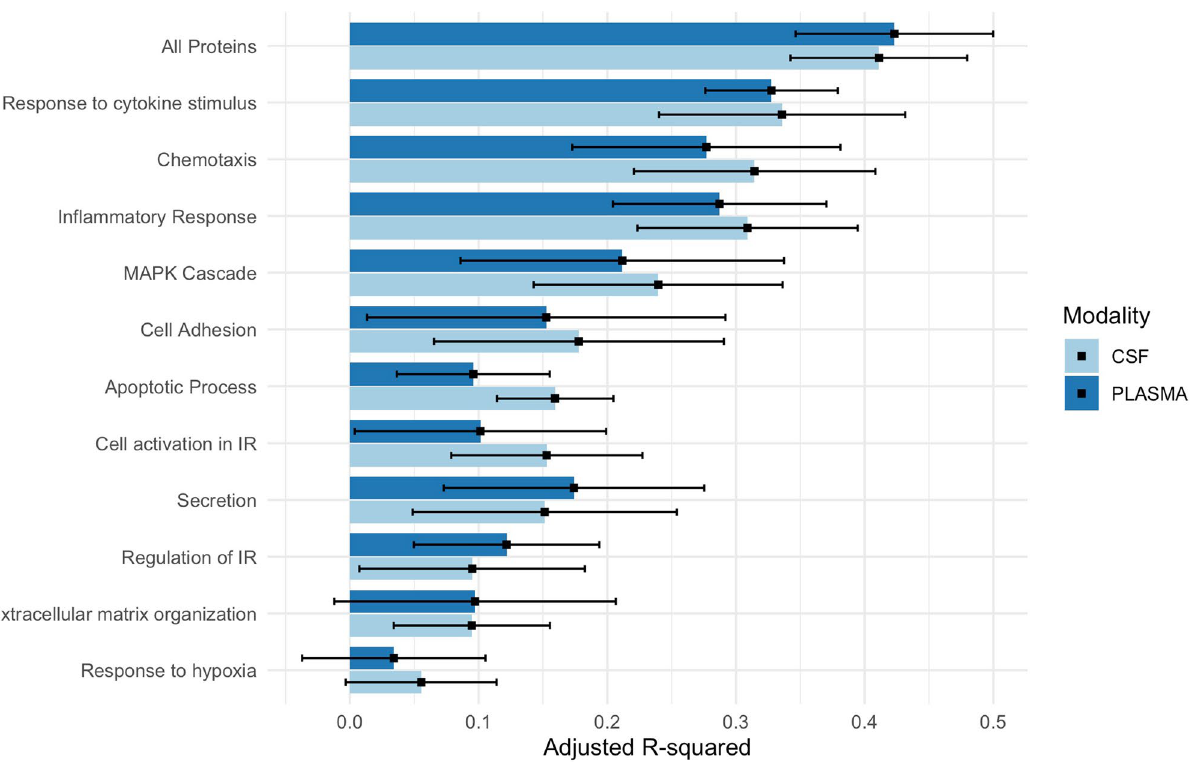
Figure 1. Predicting age from inflammatory proteins in Aβ-CU individuals. This figure shows the variance explained by linear regression models used to predict chronological age in amyloid-negative, cognitively unimpaired individuals from CSF and plasma proteins grouped into a range of inflammatory